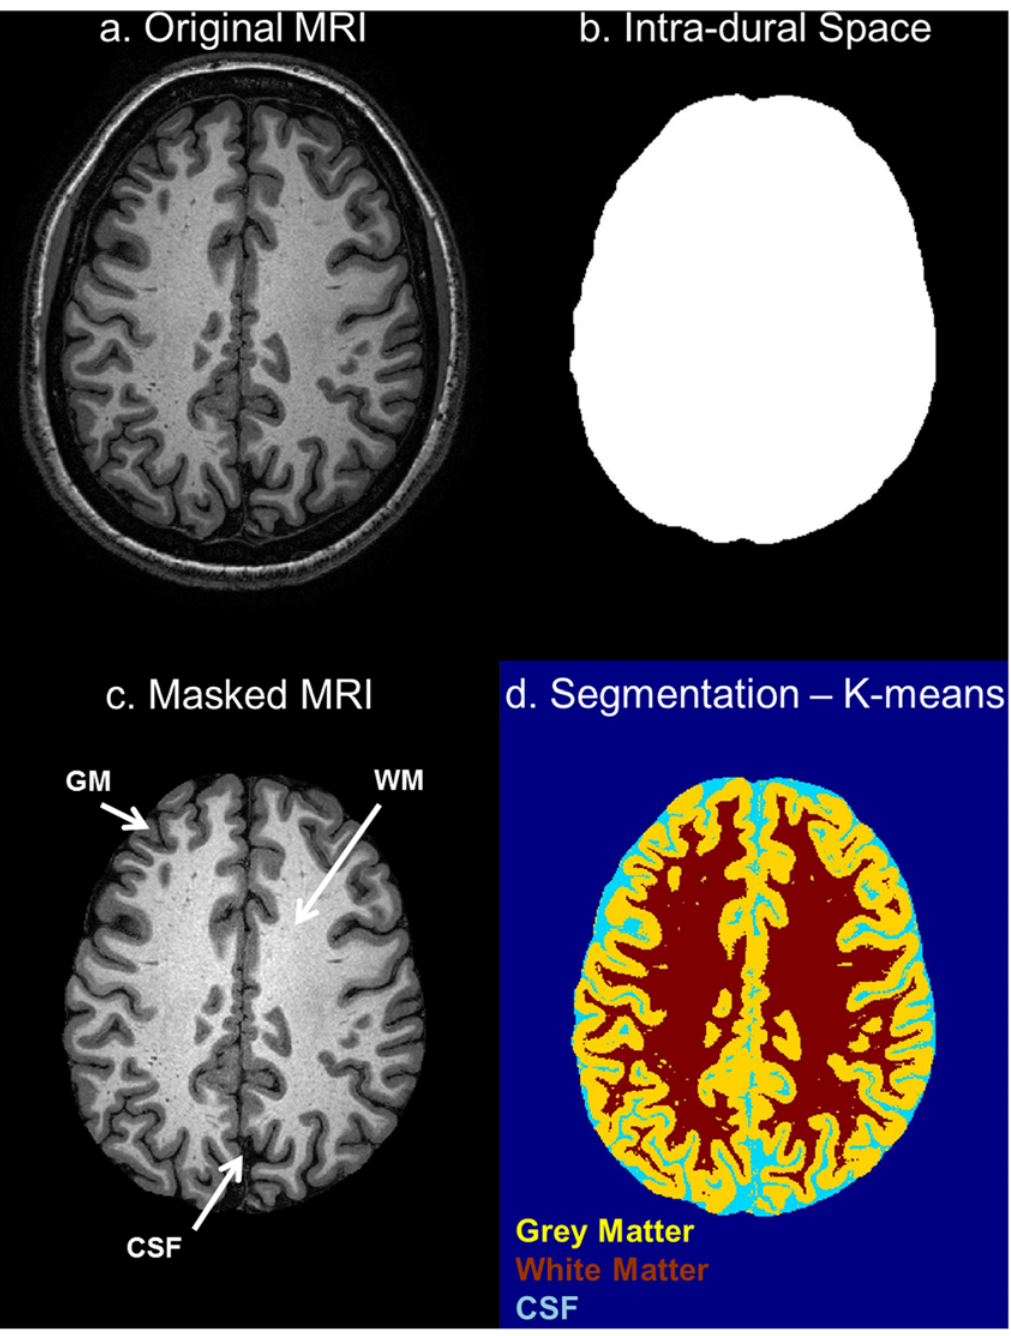
Fig 11. Segmentation of the cerebrum. (a) Original axial T1-weighted MRI, (b) intra-dural space obtained as the space surrounded by the previously segmented dura mater, (c) masked T1-weighted MRI, and (d) the image resulting from application of the k -means algorithm.